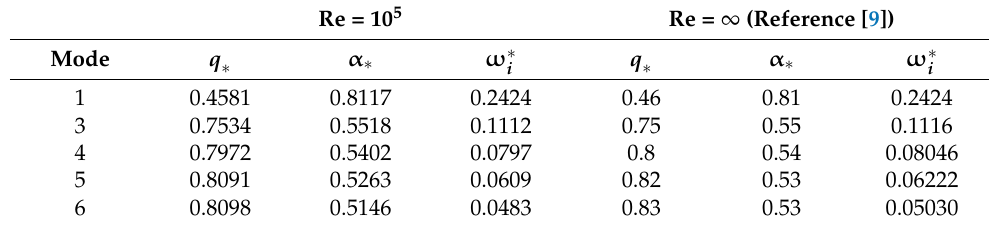
Table 3. Comparison with the results of the inviscid theory.